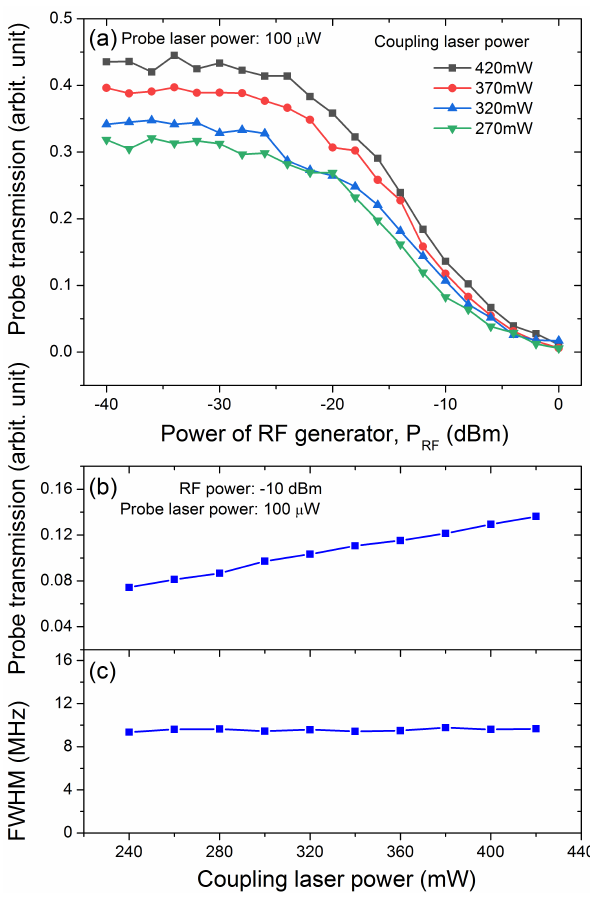
Figure 4. ( a ) Probe optical transmission response on the applied RF power at various coupling laser powers. ( b ) At the optimized RF power of − 10 dBm and probe laser intensity of 100 µ W, the optical signal increases linearly with coupling laser intensity, while ( c ) the AT-spectral linewidth nearly